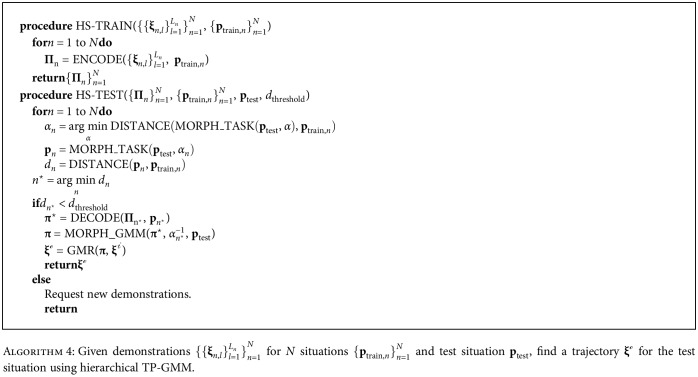
 Given demonstrations {{ξn,l}l=1Ln}n=1N for N situations {ptrain,n}n=1N and test situation ptest, find a trajectory ξℴ for the test situation using hierarchical TP-GMM.